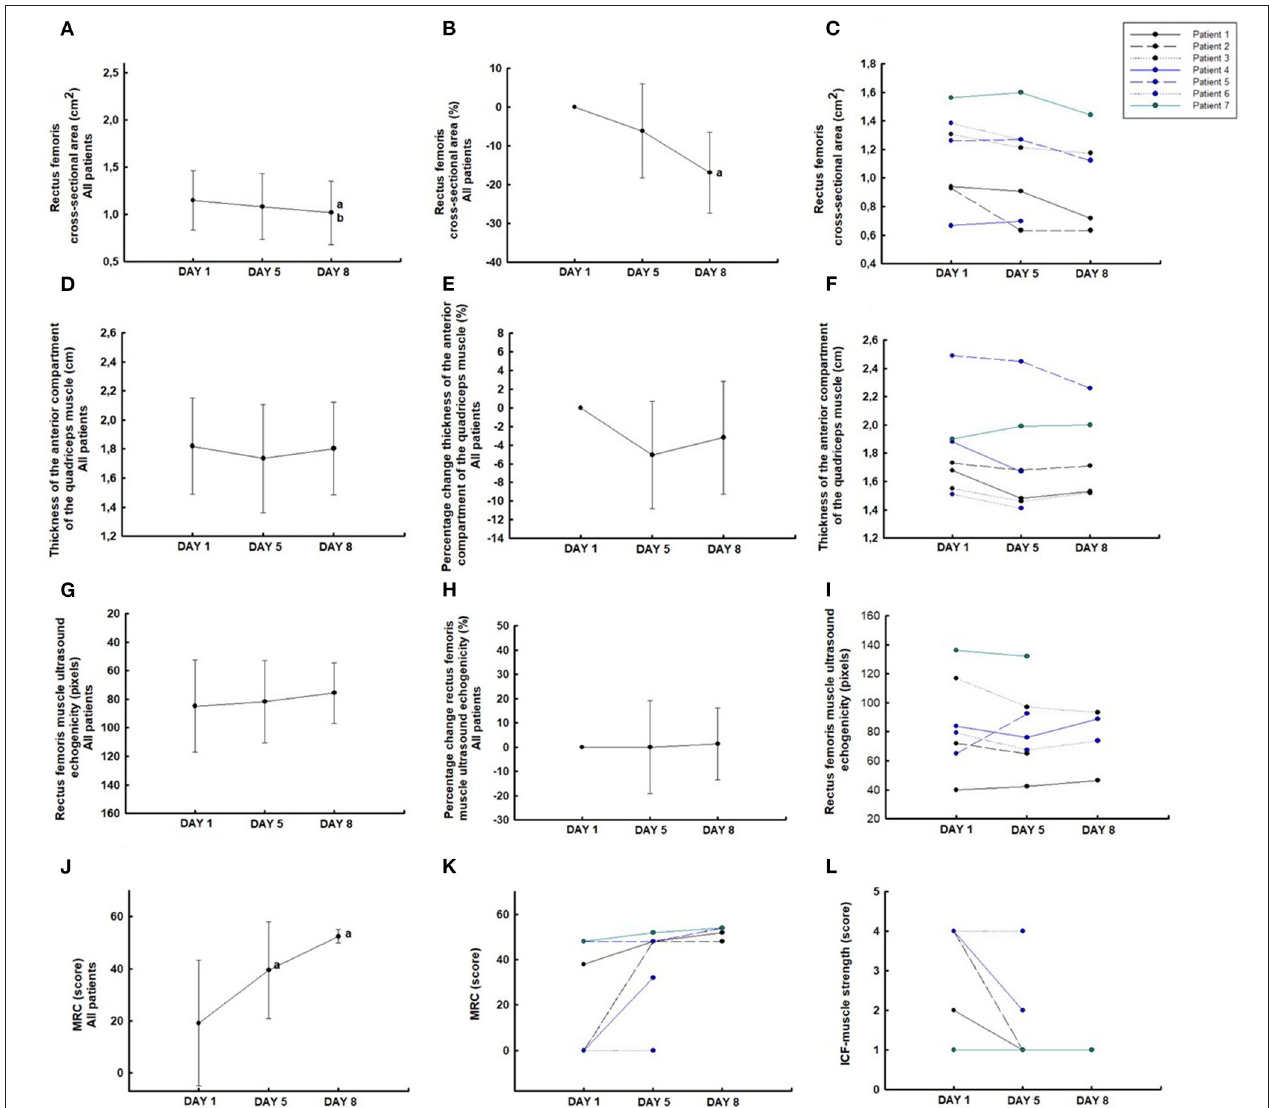
FIGURE 2 | Ultrasound muscle assessement of the rectus femoris cross-section área (A–C) ; the thickness of the anterior compartment of the quadriceps muscle (rectus femoris and vastus intermedius) (D–F) ; rectus femoris echogenicity (G–I) ; MRC score (J,K) ; and International Classification of Functioning, Disability, and Health (ICF)-muscle strength (L) . a P < 0.05 compared to day 1; b P < 0.05 compared to day 5.